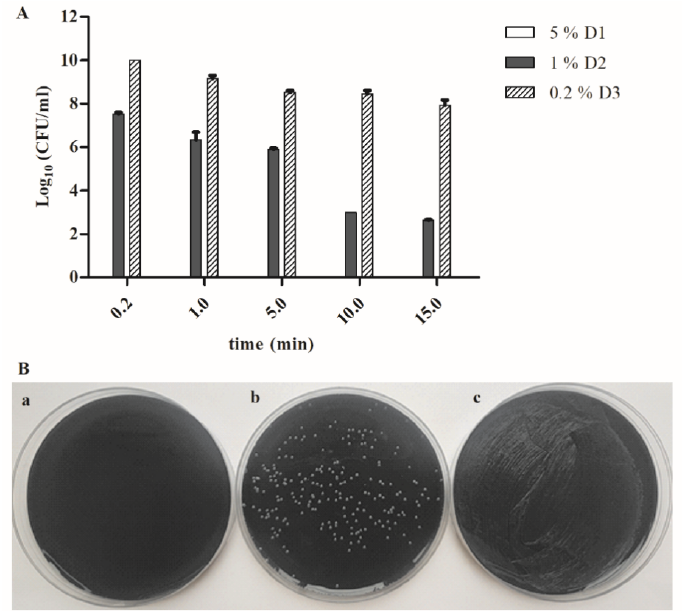
Figure 1. ( A ): The bacterial viability of agar-grown F. novicida treated with 5% disinfectant 1 (D1), 1% disinfectant 2 (D2) and 0.2% disinfectant 3 (D3) for 10 s, 1, 5, 10 and 15 min; ( B ): representative pictures of the colony count assay of agar-grown F. novicida treated with 5% D1 ( a ), 1% D2 ( b ) and 0.2% D3 ( c ) for 1 min. The bacterial suspension of F. novicida (10 9 colony-forming units (CFU)/mL) was treated with the disinfectant in a 1:1 ratio during 10 s, 1, 5, 10 and/or 15 min. The numbers of the bacteria for each exposure time were determined by CFU on buffered-charcoal yeast extract (BCYE) agar plates. The results are representative of three independent experiments. The experiments were done in triplicate, and error bars represent standard